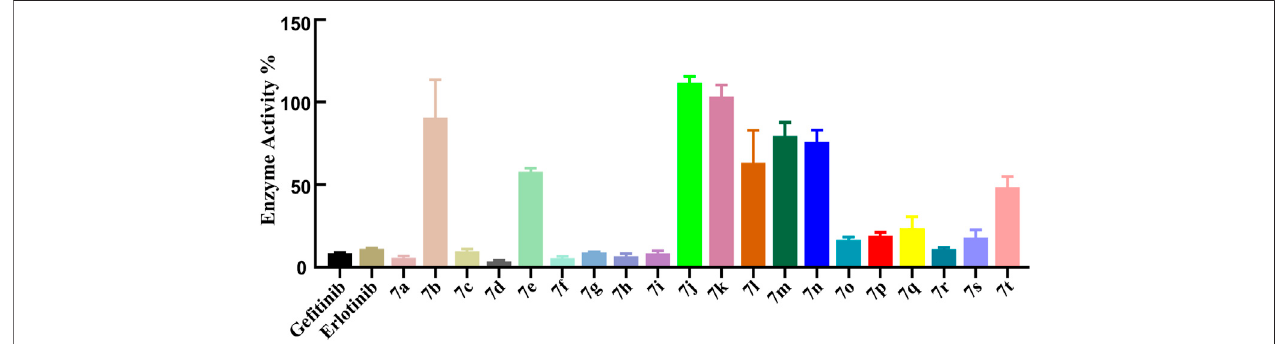
FIGURE 3 | EGFR enzyme activities of the Compound 7 series at 1 μ m.